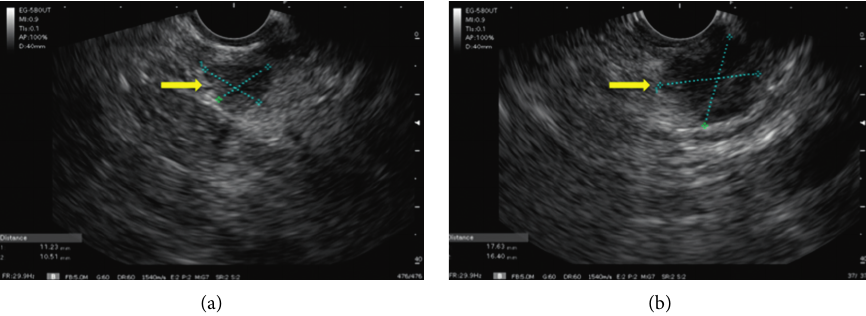
Figure 1: Sectorial scanning of uncinate process and tail of pancreas. (a) Hypoechoic lesion, homogeneous and well-delimited in the uncinate process and (b) another lesion with the same characteristics but larger in the pancreas